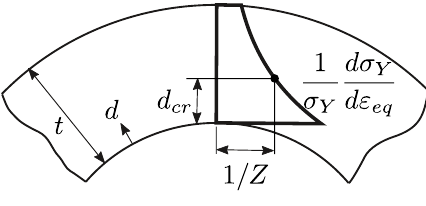
Figure 4. Critical-distance